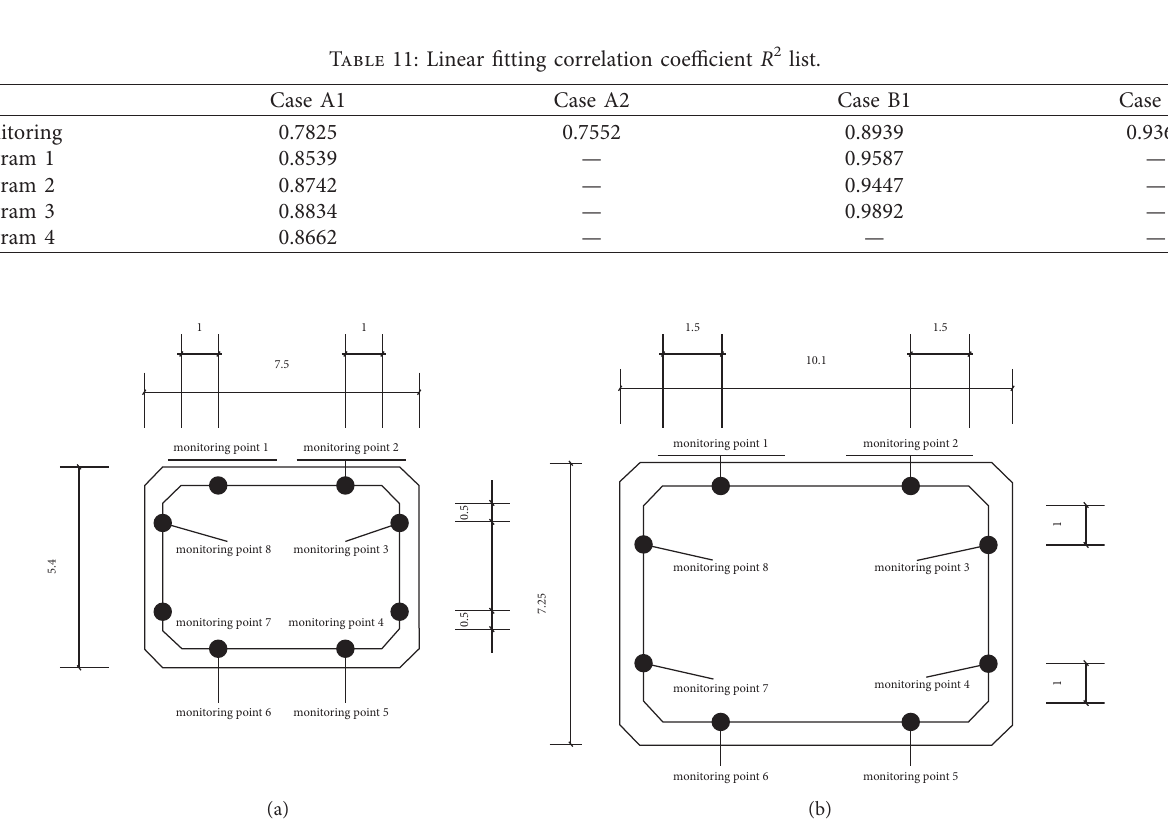
Figure 11: Grouting pressure monitoring point layout (m). (a). Case A1. (b). Case